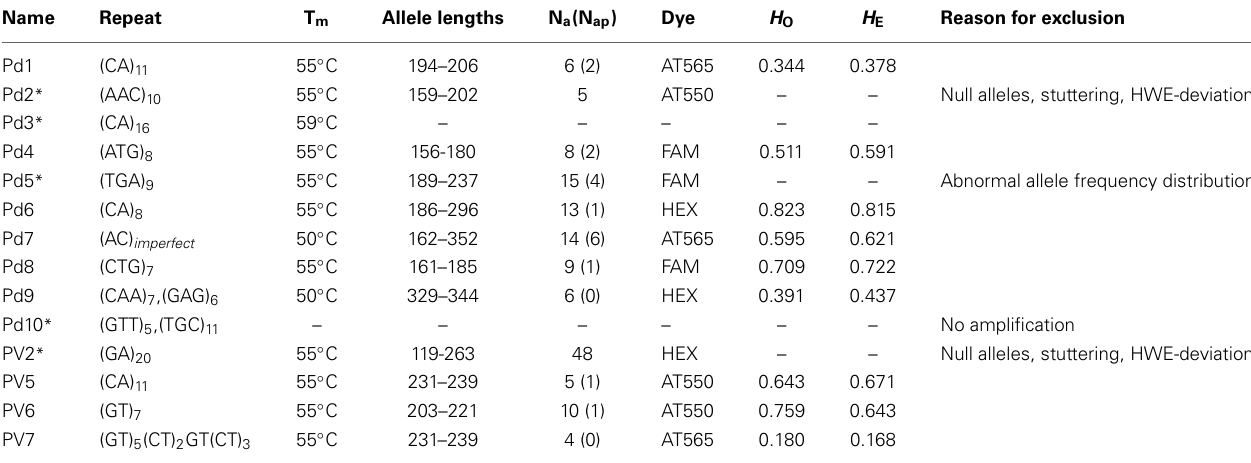
Table 2 | Microsatellites of Pocillopora used in this